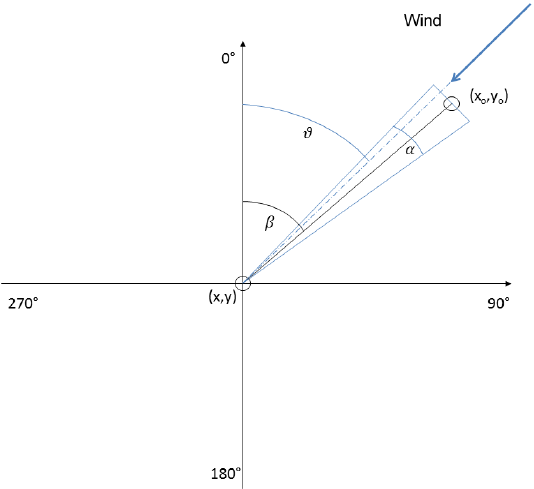
Figure 3. Determination of free-flow turbines for wind speed av- eraging. The turbine at ( x 0 , y 0 ) produces a wake on the turbine at ( x , y ) for the displayed wind direction ϑ . β is the angle between the orientation of the turbines and true north. α is the angle of the disturbed sector in accordance with IEC